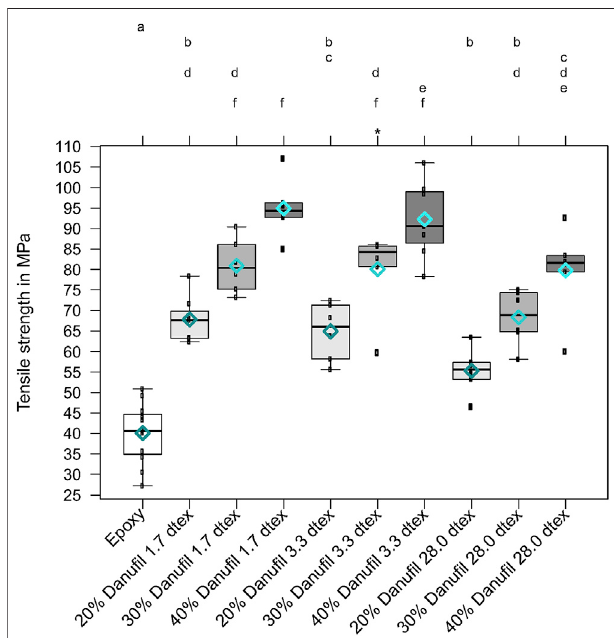
FIGURE 5 | Tensile strength of Danu fi l fi bre-reinforced composites. ResultsareshownasBox-Whisker-Plotswiththemeanvaluesasrhombuses. Different letters indicate signi fi cant differences, a * marks results that do not follow a normal